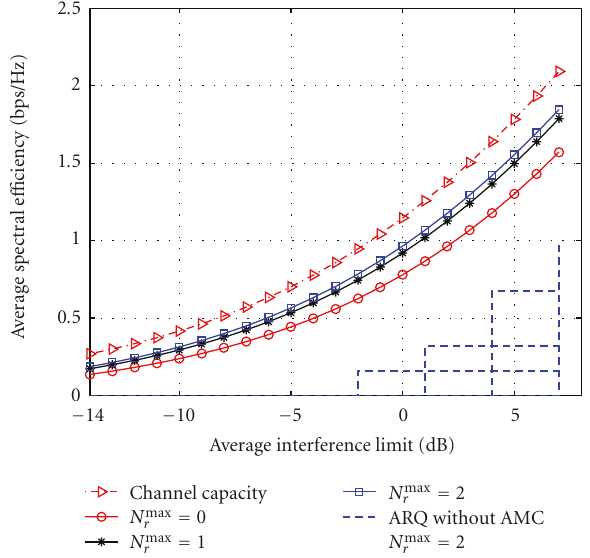
Figure 4: Average spectral e ffi ciency versus interference limit for Rayleigh distributed h s and h sp .